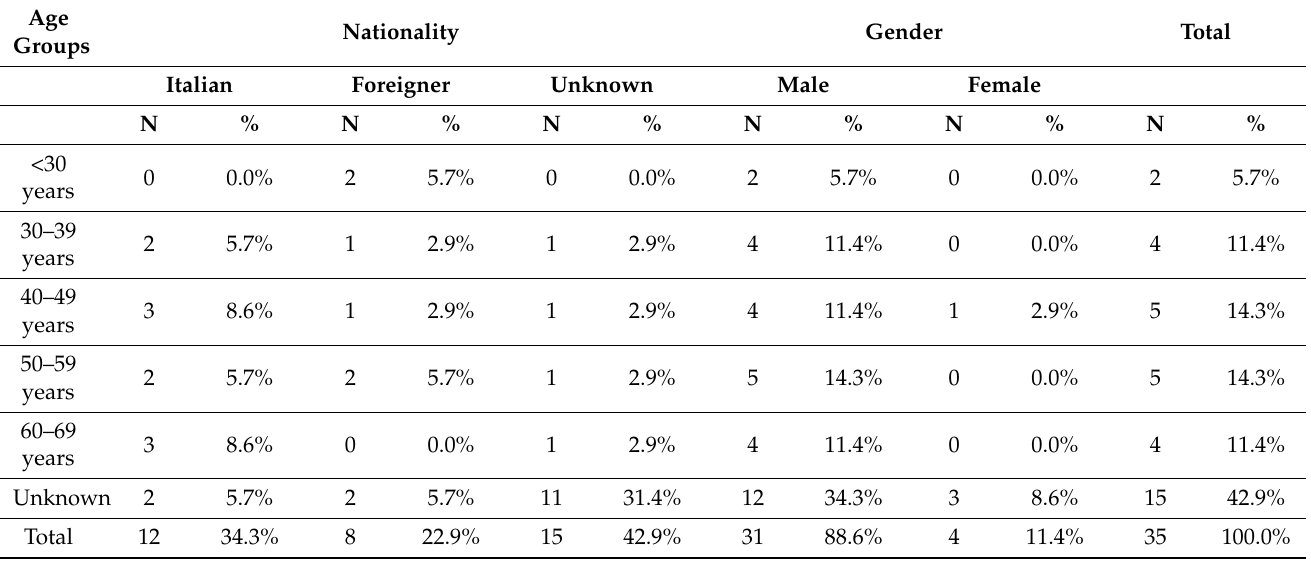
Table 3. Demographic characteristics (gender, age and nationality) as reported by Italian online newspapers in the years 2020 to 2022, by age group.